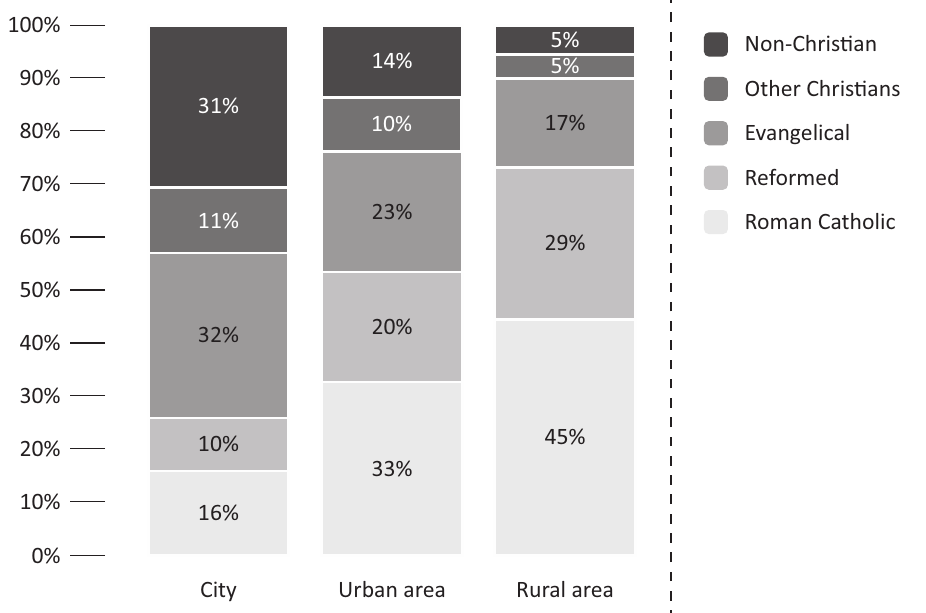
Figure 1. Division of religious traditions in Switzerland in urban and rural areas. Source: Stolz et al.